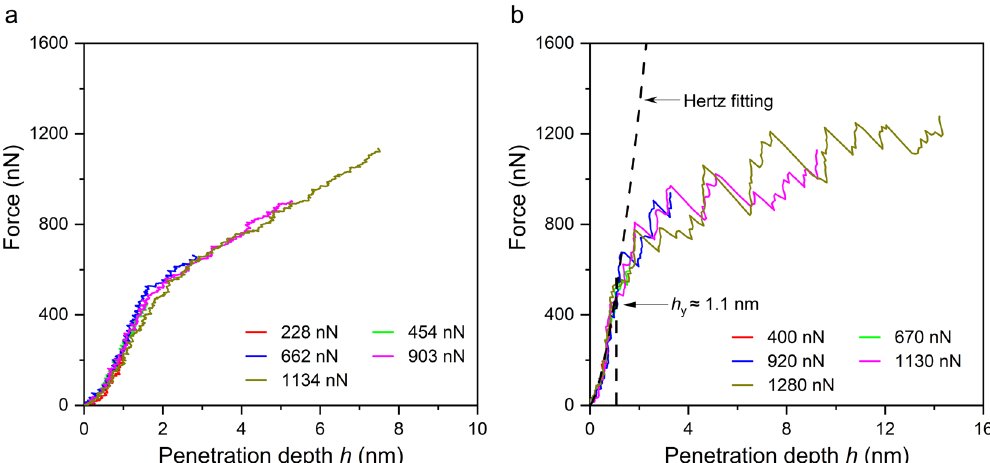
Fig. 5 Homogeneous vs inhomogeneous atomic-scale fl ow. Force vs penetration depth curves a on Pt-BMG using diamond tip #2 and (B) on Pt(111) with diamond tip #4. From the Hertz fi t in b and with assuming E Pt(111) = 168 GPa and ν Pt(111) = 0.38, the radius of tip #4 ’ s apex can be extracted as ≈ 4.5 nm, thereby matching well with the radii obtained for tips #1